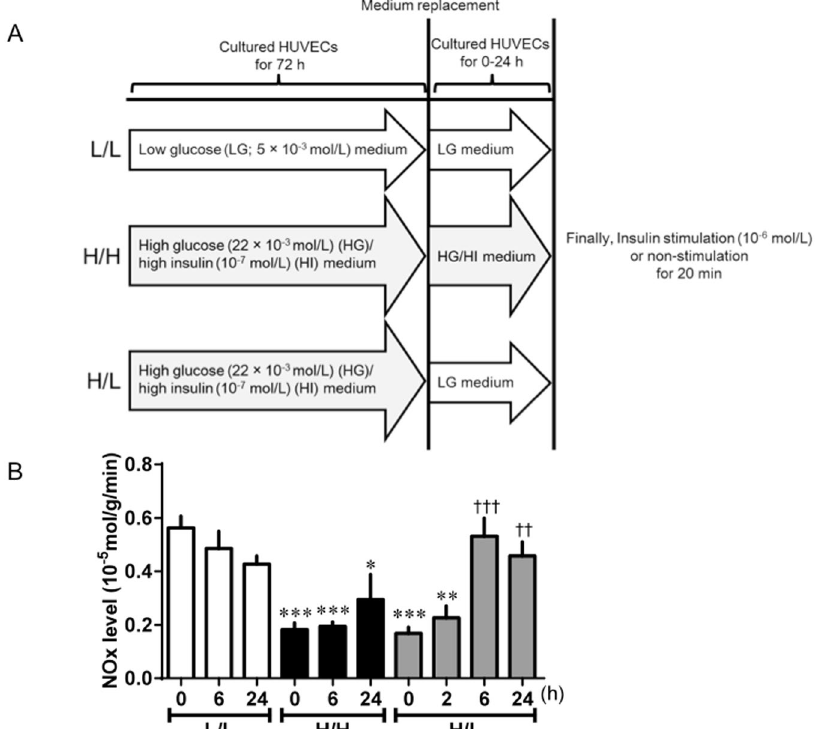
Figure 6. Normalization of glucose concentration improved impaired insulin-stimulated NO production in HUVECs induced GRK2 under high glucose (HG) and high insulin (HI). ( A ) Experimental protocol for HUVECs. L/L (Control) HUVECs were incubated in LG (5 × 10 − 3 mol/L) medium for 72 h, which was then replaced with the same medium. H/H (quasi-diabetic state) HUVECs were incubated in HG (22 × 10 − 3 mol/L)/HI (10 − 7 mol/L) medium for 72 h, which was then replaced with the same medium. H/L HUVECs were incubated in HG/HI medium for 72 h, which was then replaced with LG medium. ( B ) NO released from HUVECs was measured under insulin stimulation or non-stimulation. Data presented as insulin-stimulated NO production values after deduction of non-stimulated NO production values. HUVECs were treated with insulin (10 − 6 mol/L) for 20 min, 0, (2), 6 or 24 h after medium replacement. Values are mean ± SE; n = 6. * p < 0.05, ** p < 0.01, *** p < 0.001 vs. L/L (0 h); †† p < 0.01, ††† p < 0.001 vs. H/L (0 h) by one-way analysis of